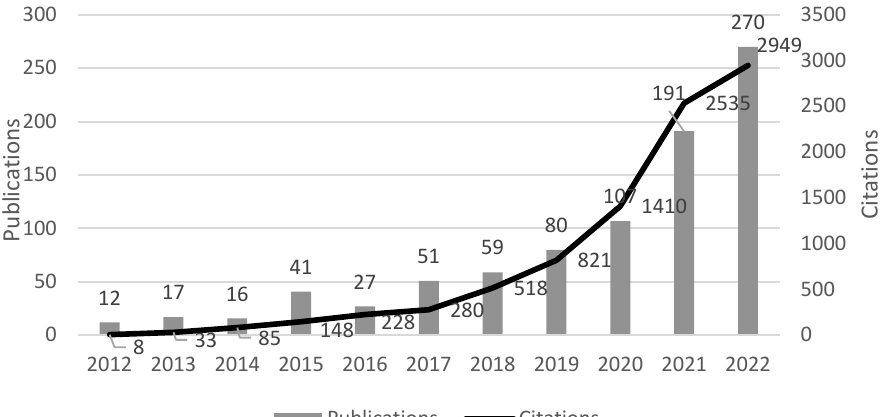
Figure 1. The evolution of publications and citations by year.